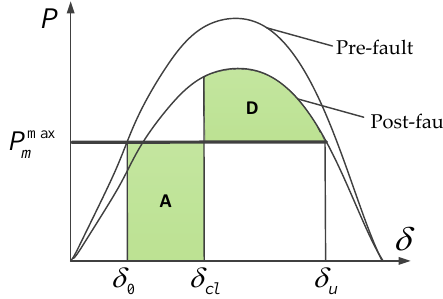
Figure 4. Diagram of power-angle curves when the system is in a transient stability critical state.